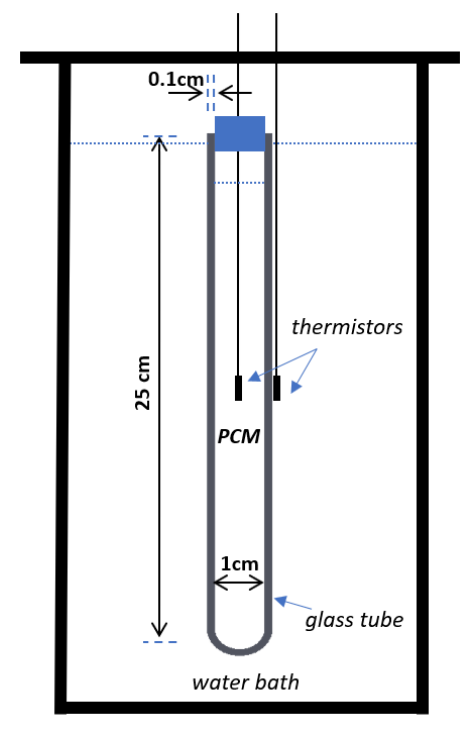
Figure 2. Experimental